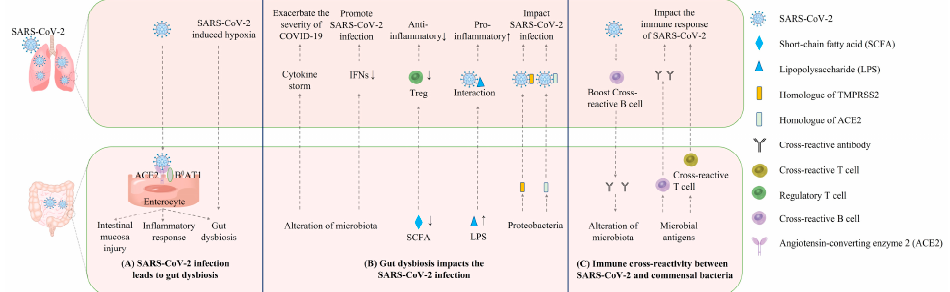
Figure 1. Potential mechanisms underlying the mutual impacts between intestinal microbiota and SARS-CoV-2. ( A ) SARS-CoV-2 can cause gut dysbiosis by infecting enterocytes or causing systematic hypoxia. ( B ) Gut dysbiosis can impact SARS-CoV-2 infection in the lungs via regulating immune responses in the lung or secreting homologues of ACE2 and TMPRSS2. ( C ) The microbial antigens may elicit cross-reactive antibody and T cell responses against SARS-CoV-2. SARS-CoV-2 infection may reinforce cross-reactive antibody responses against microbial antigens and thereby lead to the alteration of gut microbiota.